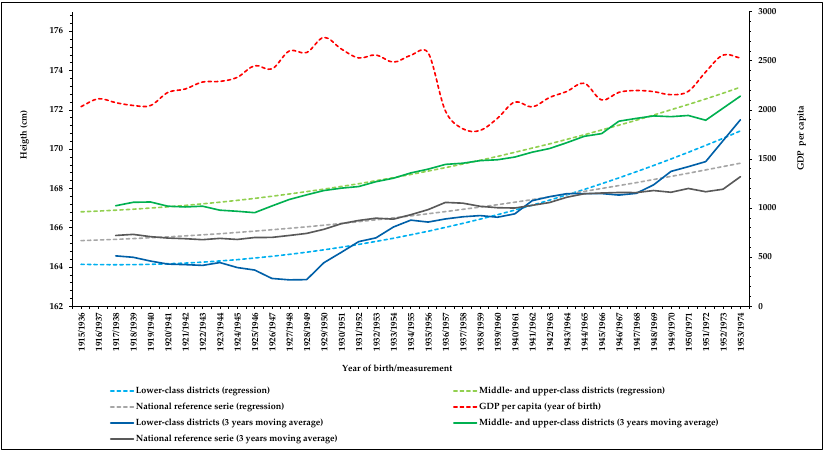
Middle- and upper-class districts (3 years moving average) National reference serie (3 years moving average) Figure 4. Secular trends in height in lower-class districts and middle- and upper-class districts, compared with national reference series, and trend of GDP per capita by year of birth (Sources: AGMG, [35] and [39]); R 2 national reference series =